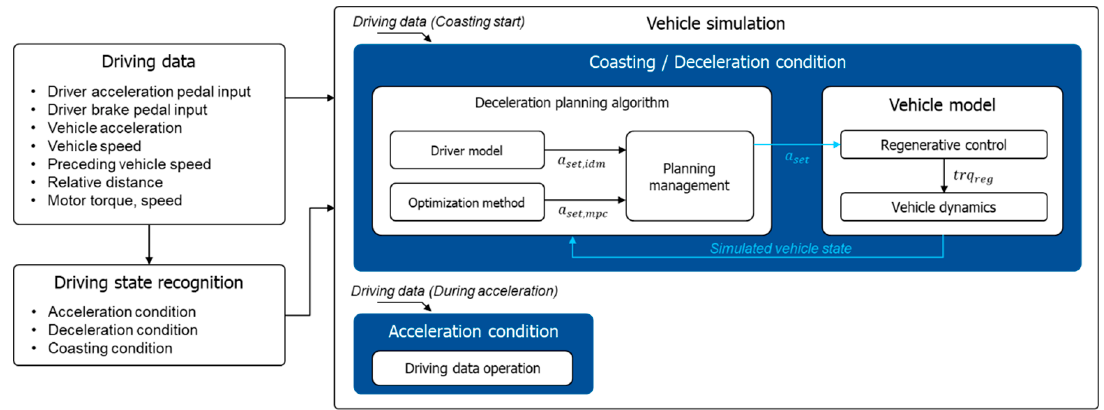
Figure 1. Algorithm overview.